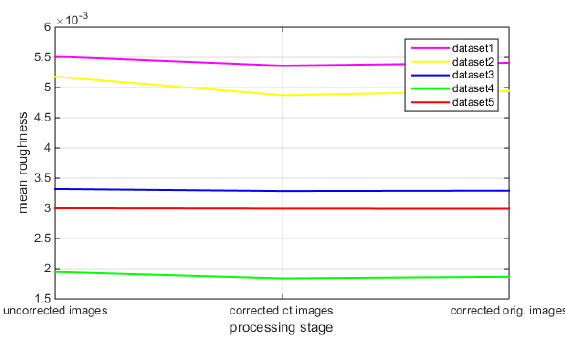
Figure 8. The total number of points of each dataset for the 3 processing stages.